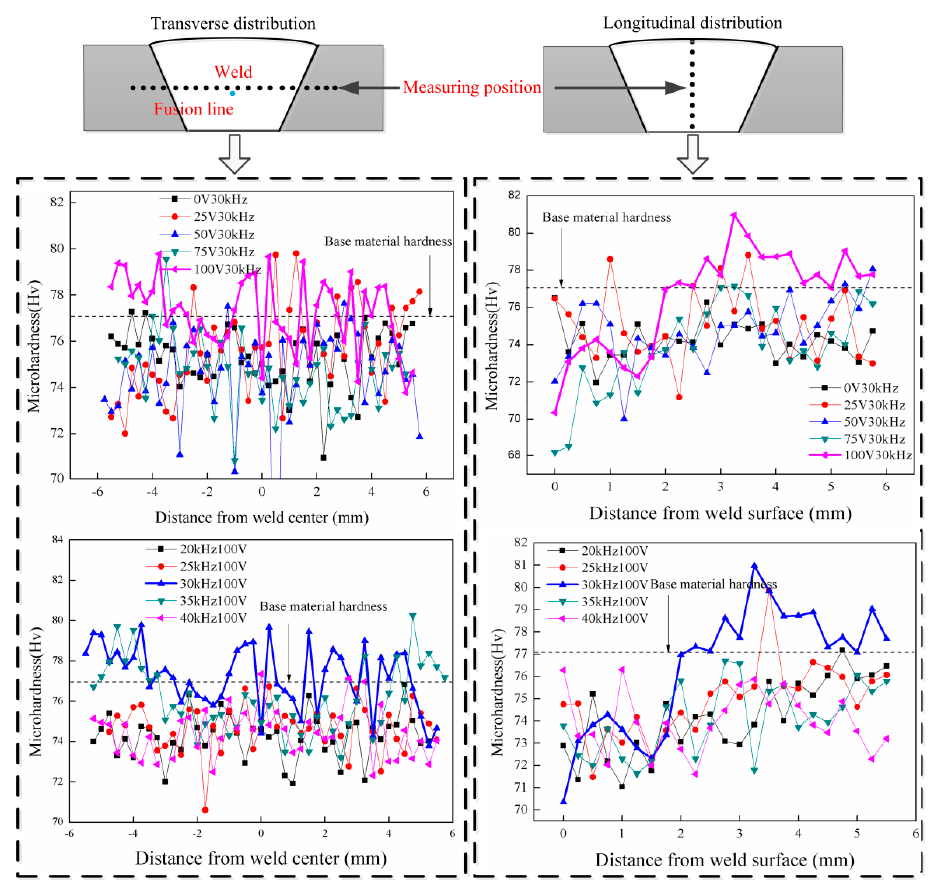
Figure 8. The hardness of welded joint with different ultrasonic excitation voltages and frequencies.